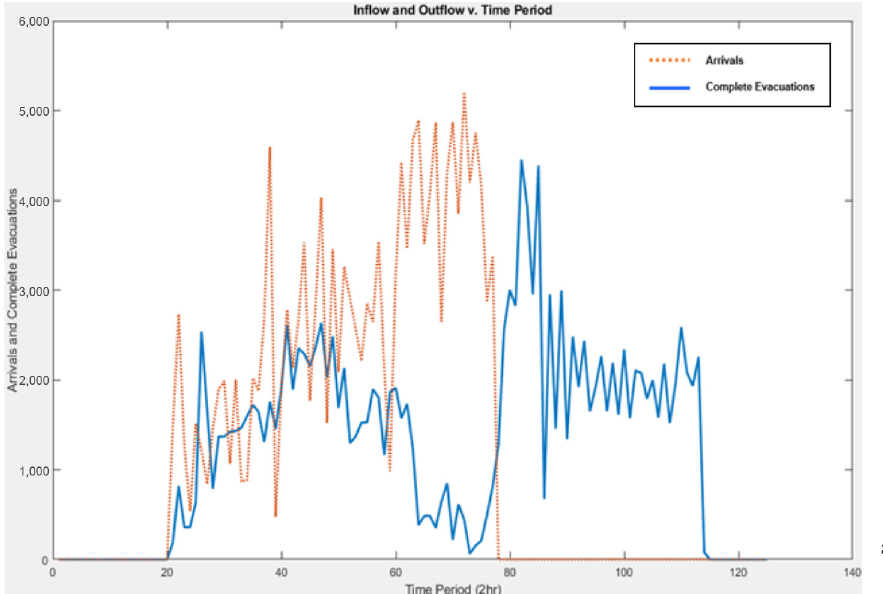
Figure 8. (color online) In fl